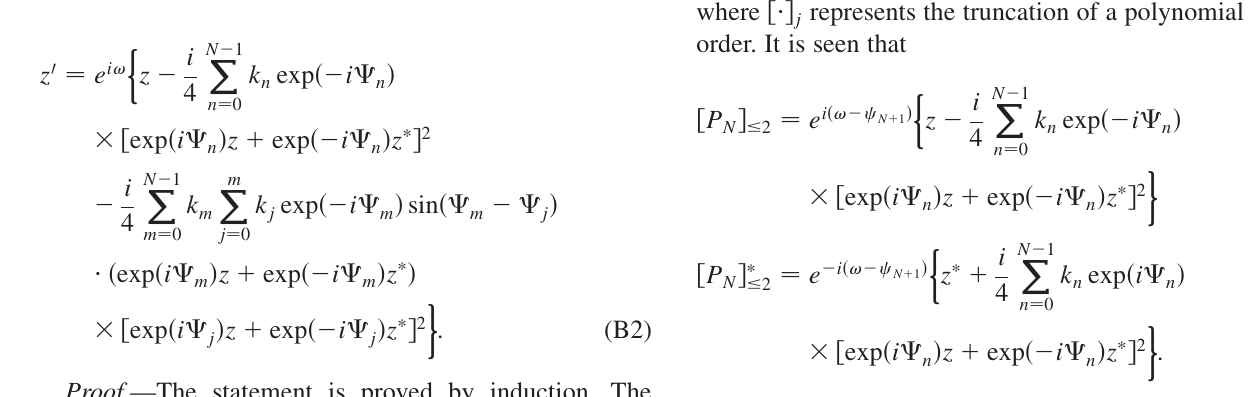
FIG. 10. Sketch of a machine circumference with the arrange- ment of several nonlinear lattice elements representing either sextupoles or